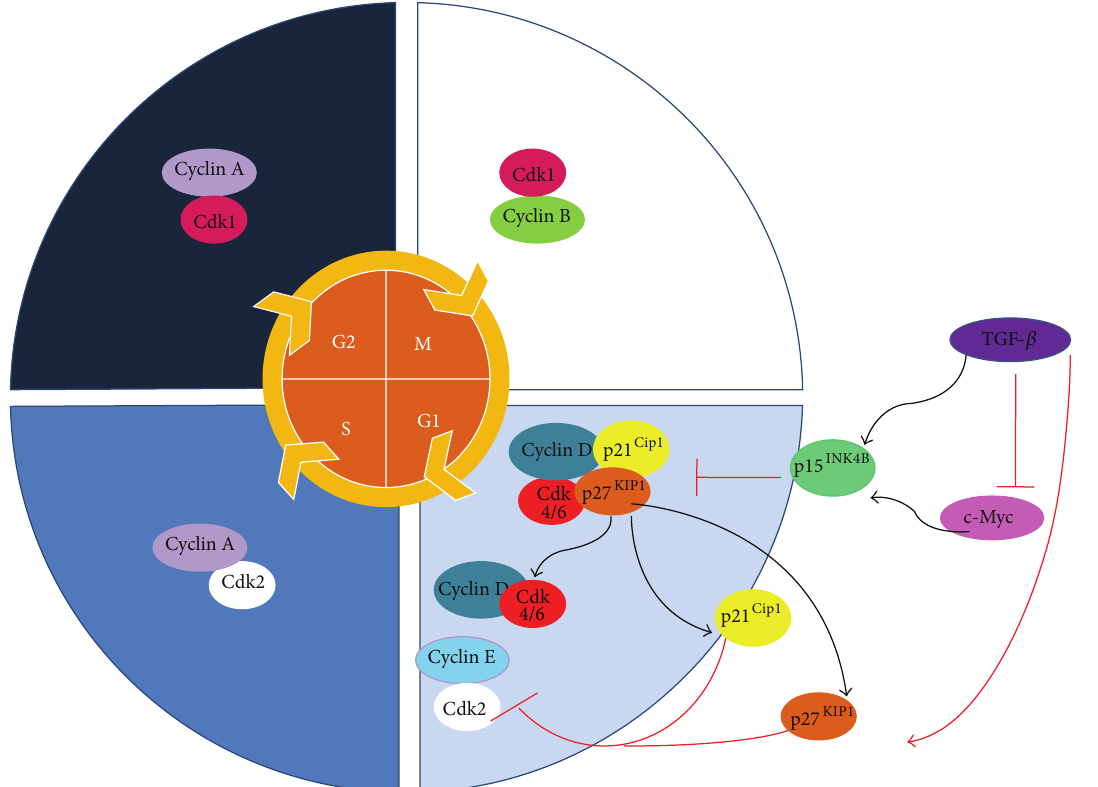
Figure 3: The role of TGF- 𝛽 in cell cycle regulation. Physiologically, TGF- 𝛽 is a potent cell cycle inhibitor, inducing the expression of p 15 INK 4 B and suppressing c-Myc expression. p 15 INK 4 B prevents the formation of cyclin D-CDK4/6 complexes and displaces p 21 Cip 1 and p 27 KIP 1 from the cyclin D-CDK4/6 complex. The inhibitors CIP/KIP can then inactivate other G1 to S phase complexes and inhibit the cell cycle. Low c-Myc levels allow TGF- 𝛽 to induce the transcription of p 15 INK 4 B and p 21 Cip 21 .